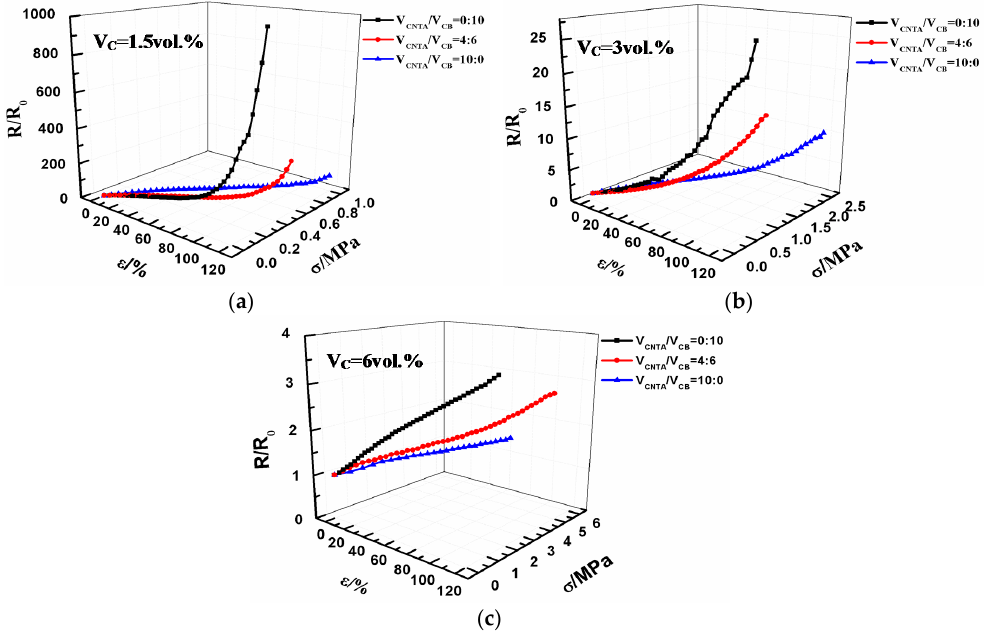
Figure 2. Strain-sensing behavior measurement for CB/PMVS, CNTA/CB/PMVS, CNTA/PMVS composites at different volume fractions of fillers: ( a ) 1.5 vol %, ( b ) 3 vol %, and ( c ) 6 vol %. Figure 2 reveals the correspondence among tensile strain, stress, and the change of resistance. Different composite materials filled with CB or CNTAs were investigated to review tensile sensitivity of our composites under uniaxial strain. The resistance of all the composites increases gradually with